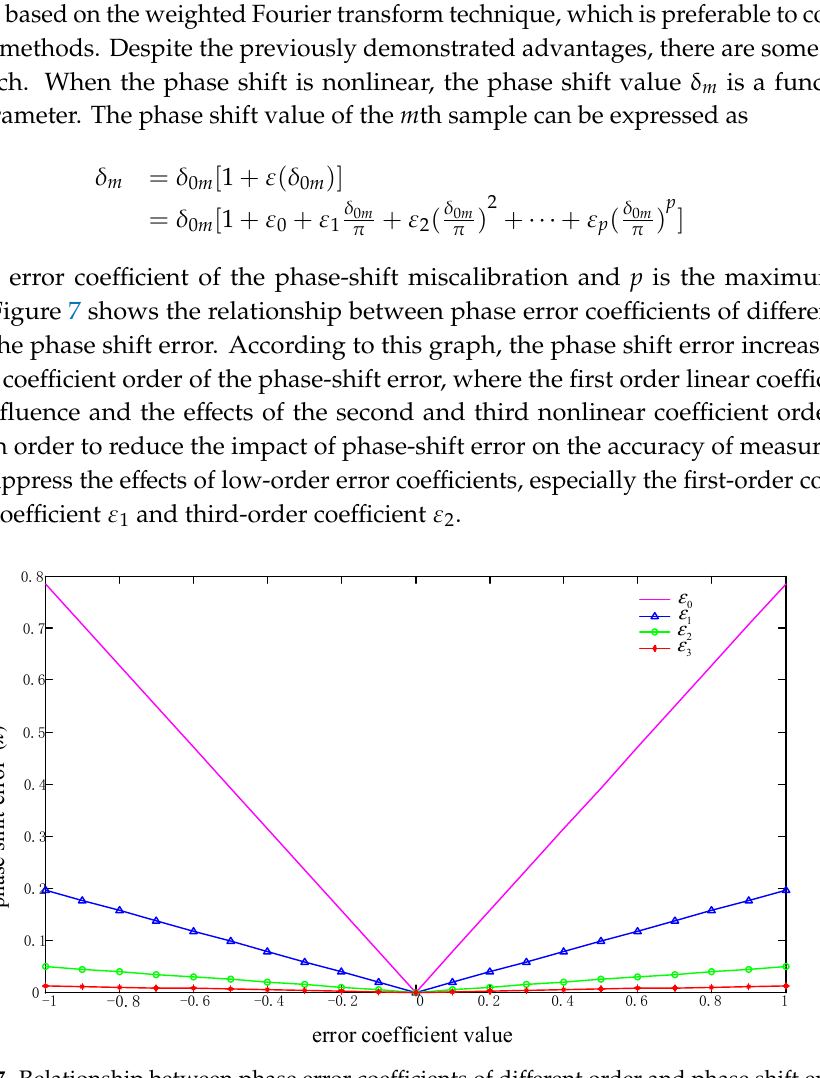
Figure 7. Relationship between phase error coefficients of different order and phase shift error.